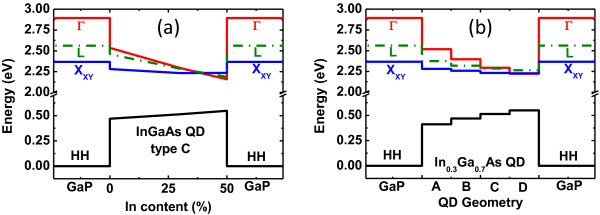
Influence of In content and QD geometry on the electronic levels. (a) Electronic levels of InxGa1−xAs QD with geometry C. (b) Electronic levels of In0.3Ga0.7As QDs for the four geometries defined in Figure
2. The Γ electronic level and the heavy-hole level in the QD are calculated with the k·p method. The X and L electronic levels are calculated with the TB model.